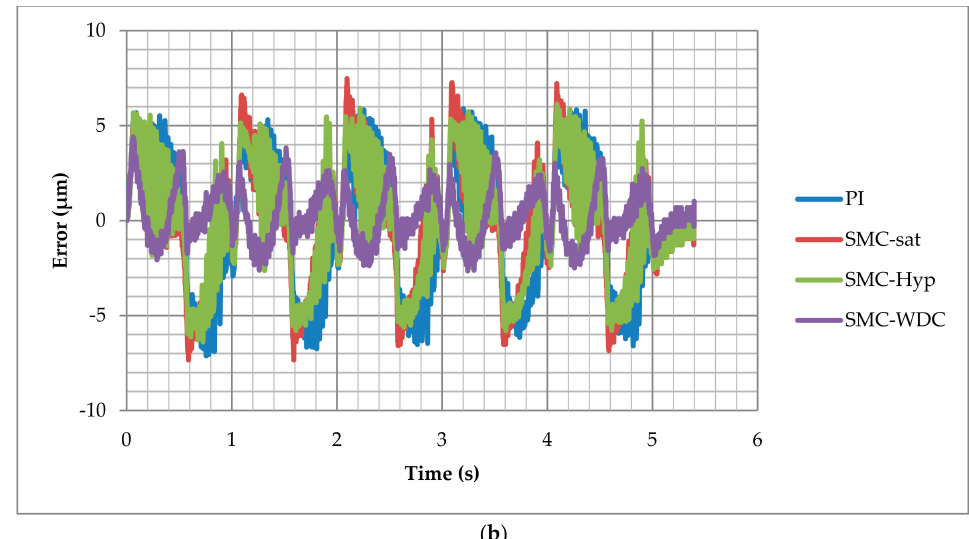
Figure 9. Sinusoidal test results of PI, SMC with saturation (SMC-Sat), SMC with hyperbolic function (SMC-Hyp), and inverse dynamic estimation SMC (SMC-WDC) tracking the setpoint (SETPOINT) along the time: ( a ) position and ( b ) tracking error.